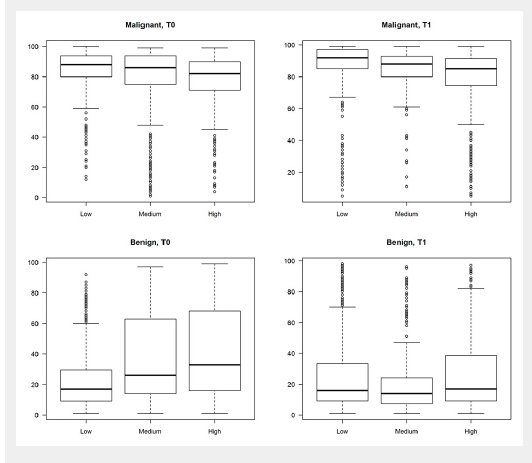
Figure 3 Outcomes by the difficulty level of the pictures and without the pre- defined cut-offs.